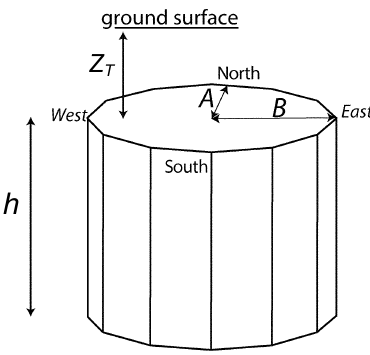
Fig. 4. Modelled geological bodies represented by elliptic pipes. Semi-axes A and B refer to body’s lateral extension in north–south and east–west directions. The parameter h characterizes the vertical extension of the pipe and z T refers to the depth to the top of the model.